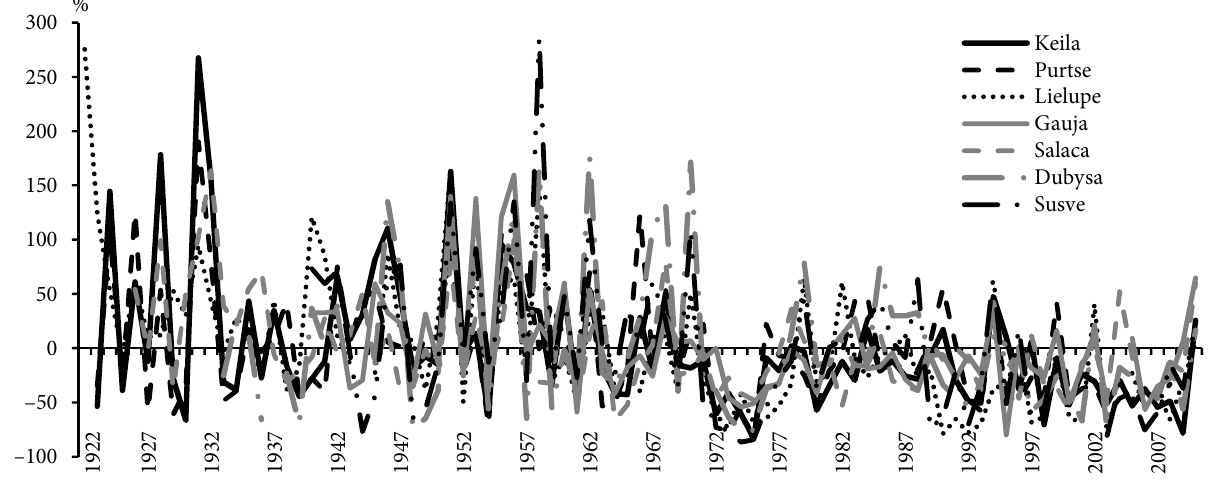
Fig. 4. Annual maximum spring flood anomalies (%) from the long-term average in the transitional